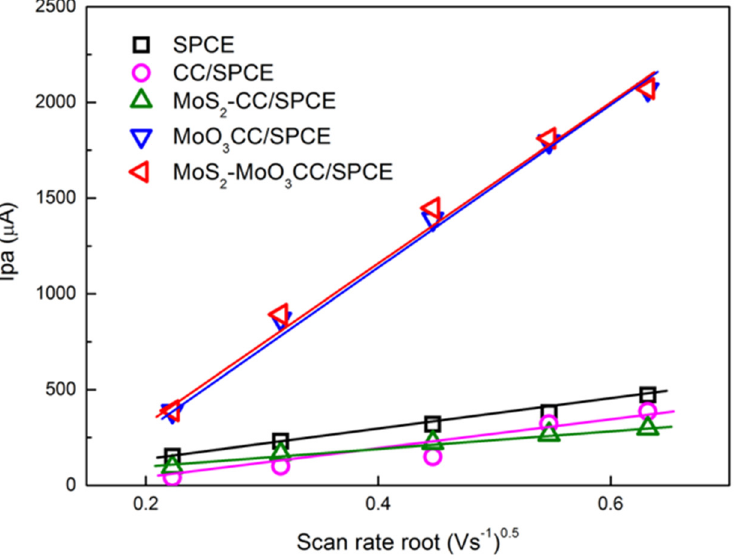
Figure 6. Plot of the anodic peak current (Ipa) vs. scan rate root. Ipa values were derived by CVs performed with the different bare and modified SPCE in 10 mM [Fe(CN) 6 ] 4 − at different scan rate.